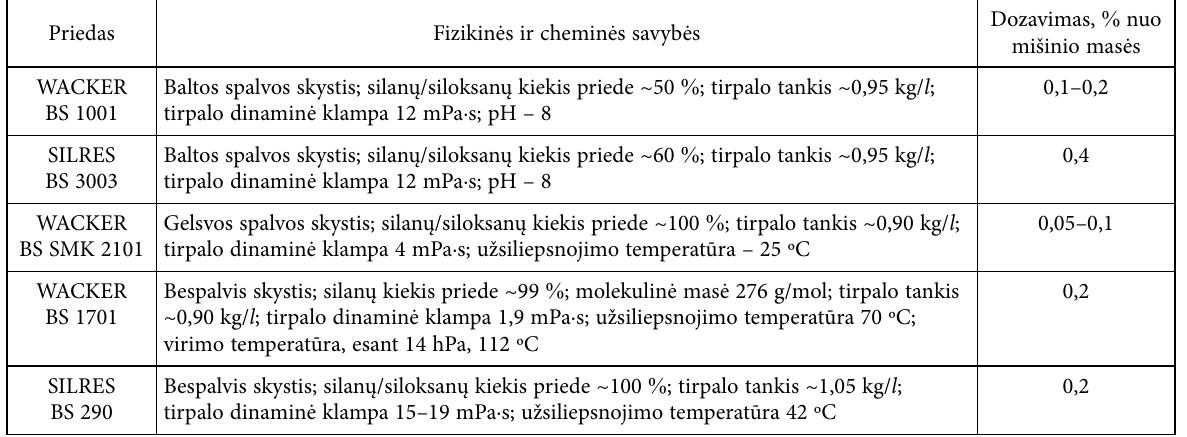
Table 2. Technical information on Wacker Silicone chemical admixtures Priedas Fizikinės ir cheminės savybės